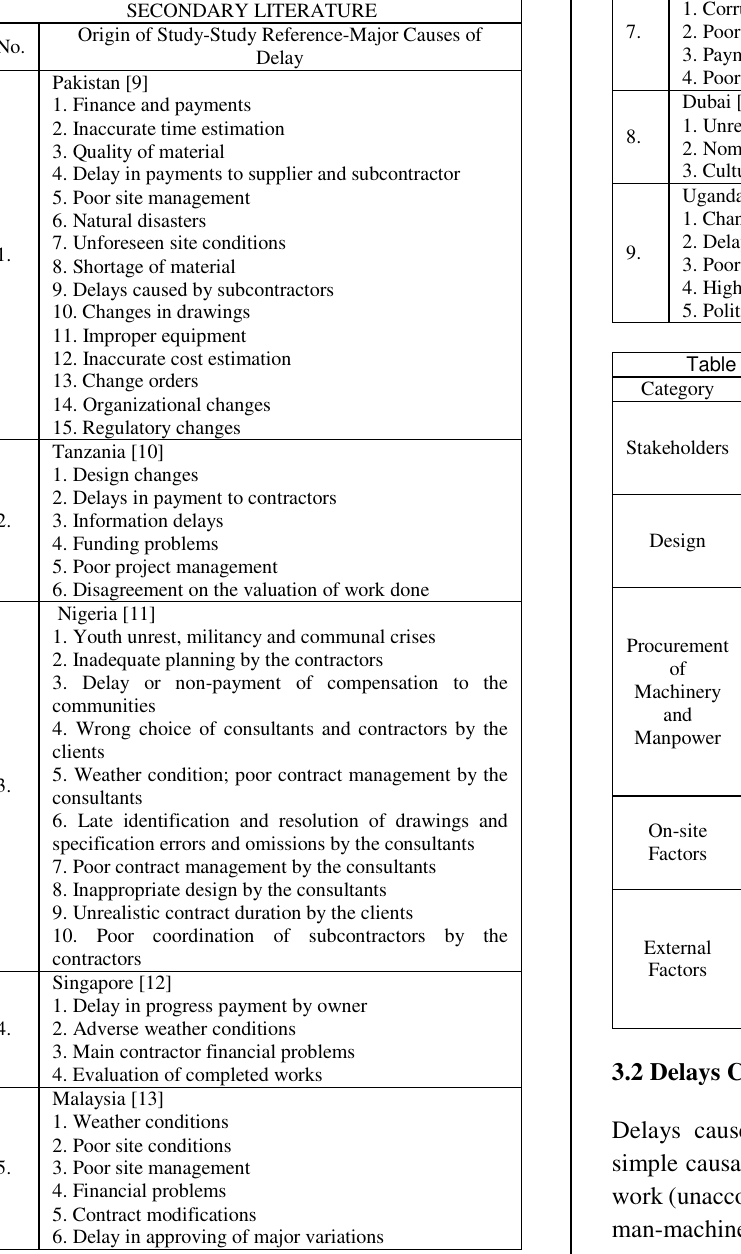
Table 2: Categorization of Causes of Delays